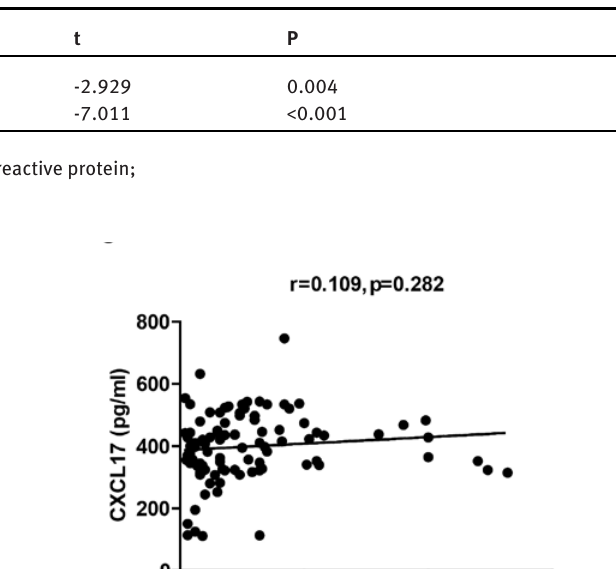
Table 2: Comparison of the serum hs-CRP and Gensini score between stable angina and unstable angina groups.